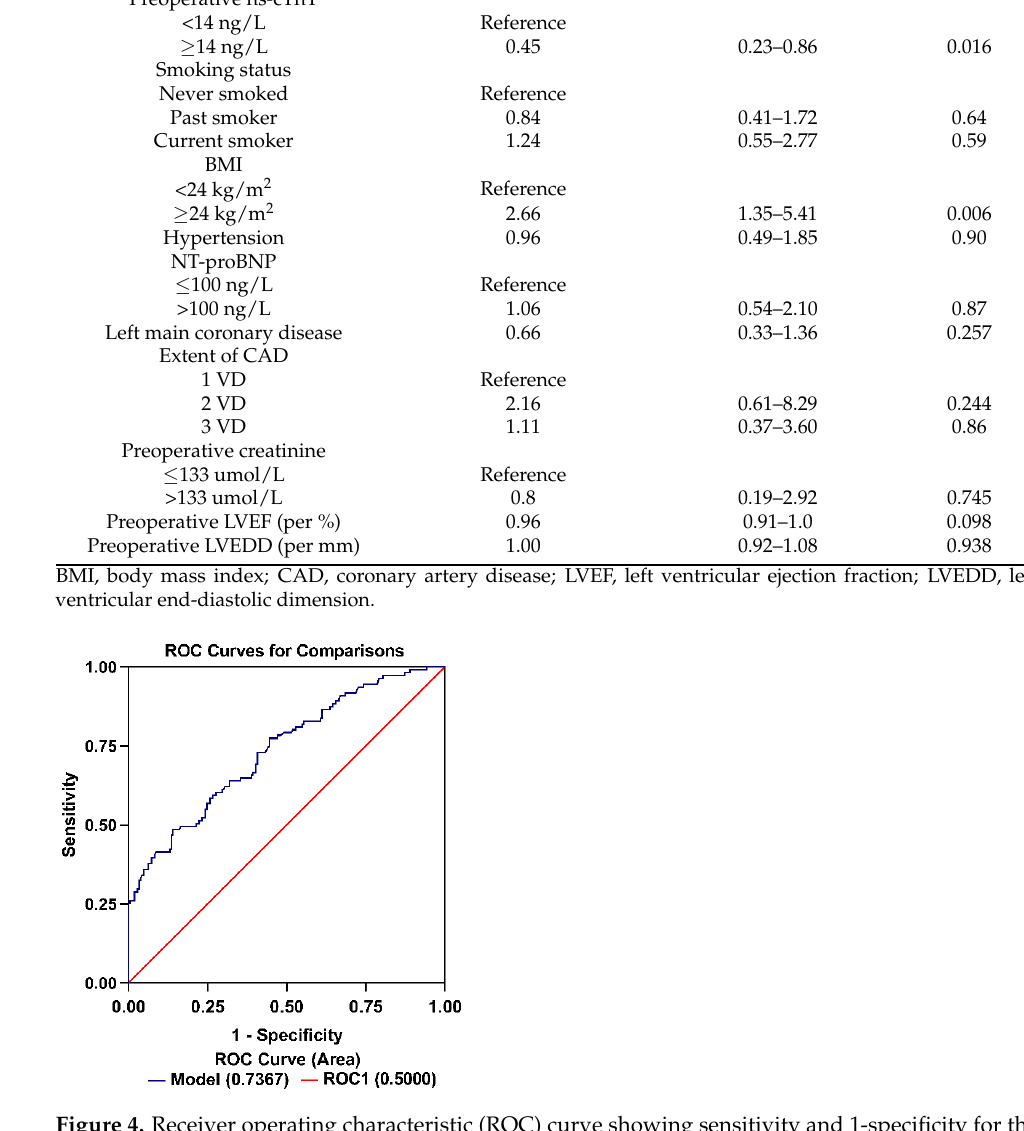
Figure 4. Receiver operating characteristic (ROC) curve showing sensitivity and 1-specificity for the model used to assess EPH rate from presurgical hs-cTnT level. Multivariable model area under the curve (AUC) was 0.7367 (95% confidence interval, 0.679 – 0.795; Hosmer – Lemeshow goodness-of-fit test p =